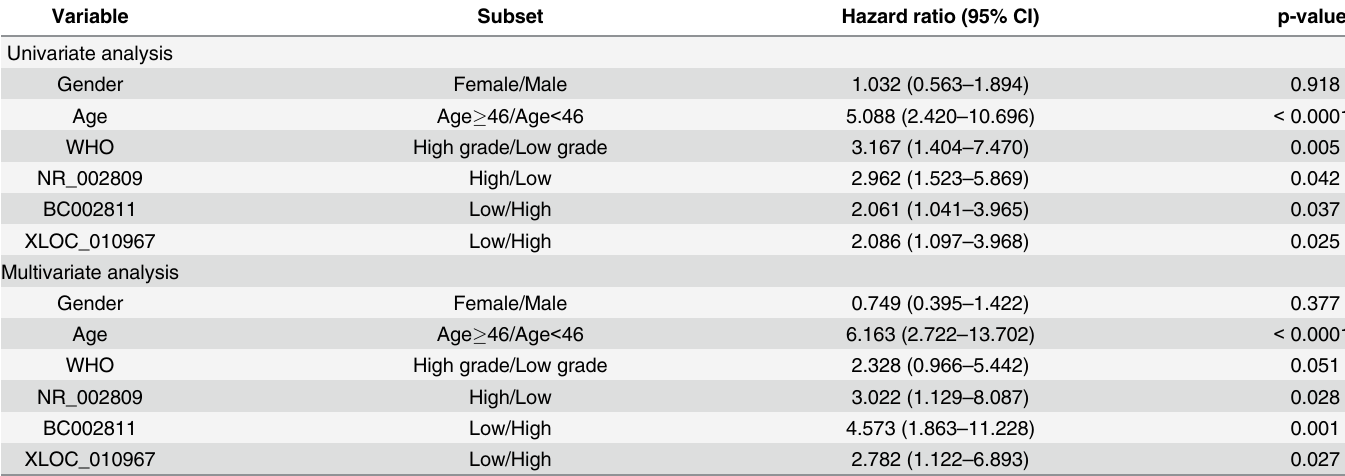
Table 3. Survival analysis of astrocytoma patients in relation to the clinicopathological characteristics and lncRNA